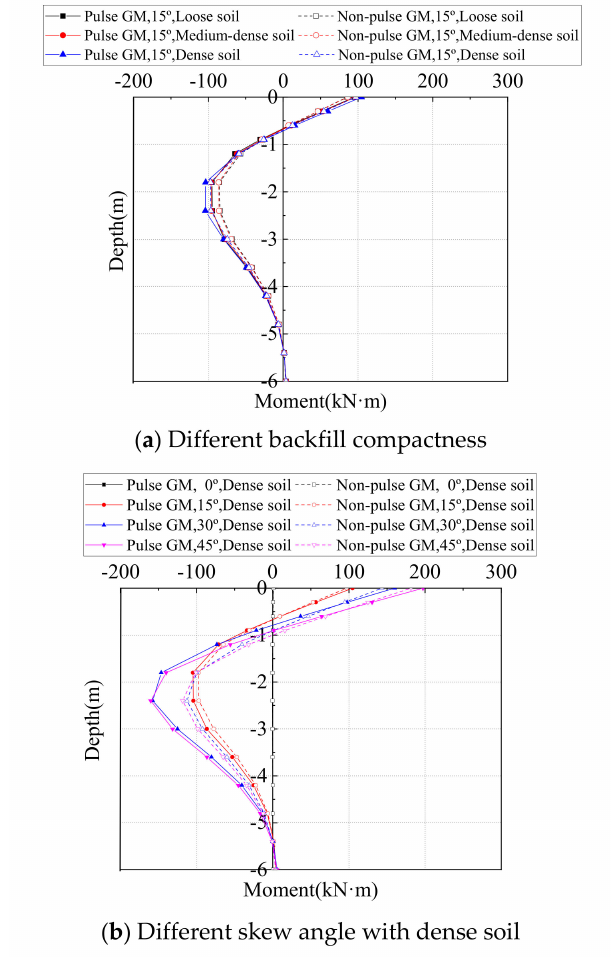
Figure 17. Distribution of pile moment around strong axis.